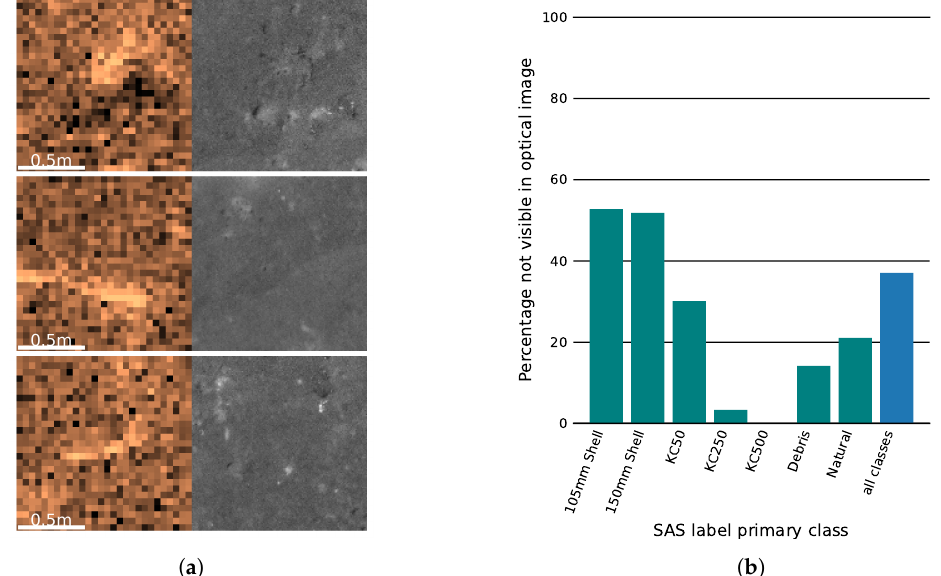
Figure 6. Observability of different objects across imaging modes: ( a ) The same section of seafloor imaged by SAS (visible objects) and optical (presumed buried objects). ( b ) Percentage of objects visible in SAS image but not optical.